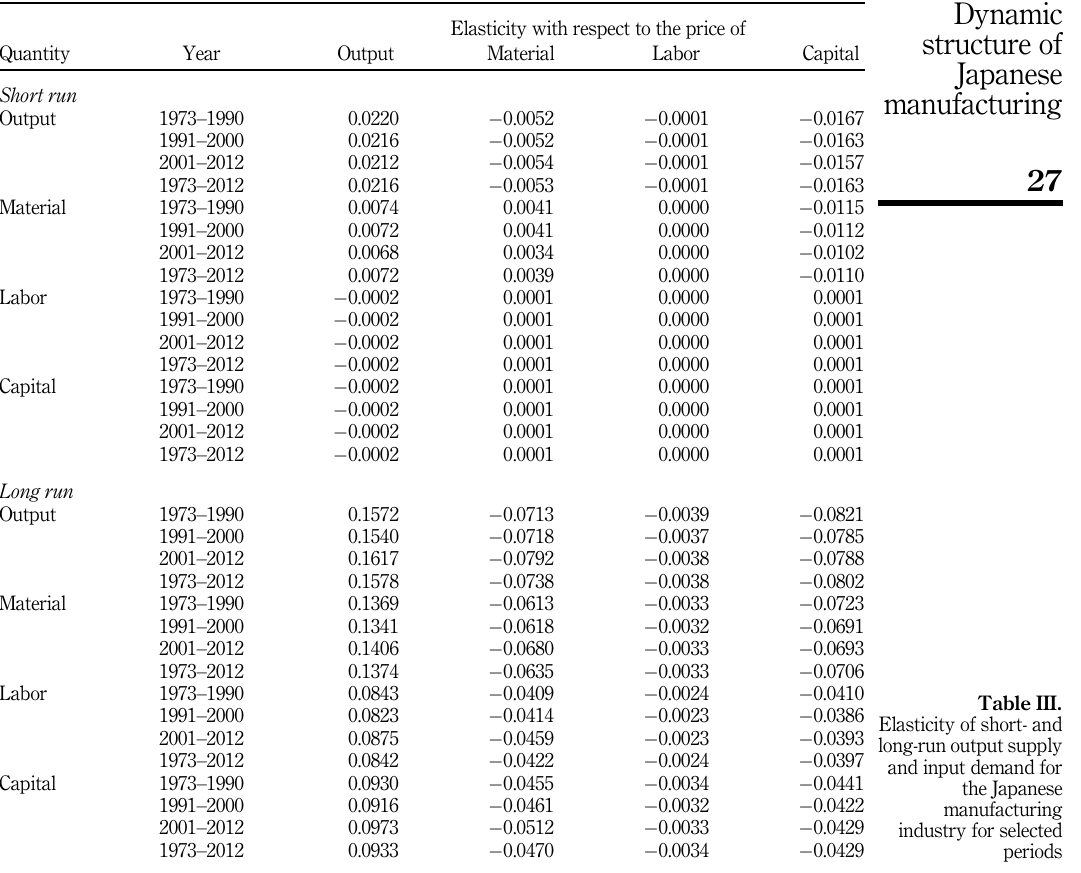
Table III. Elasticity of short-